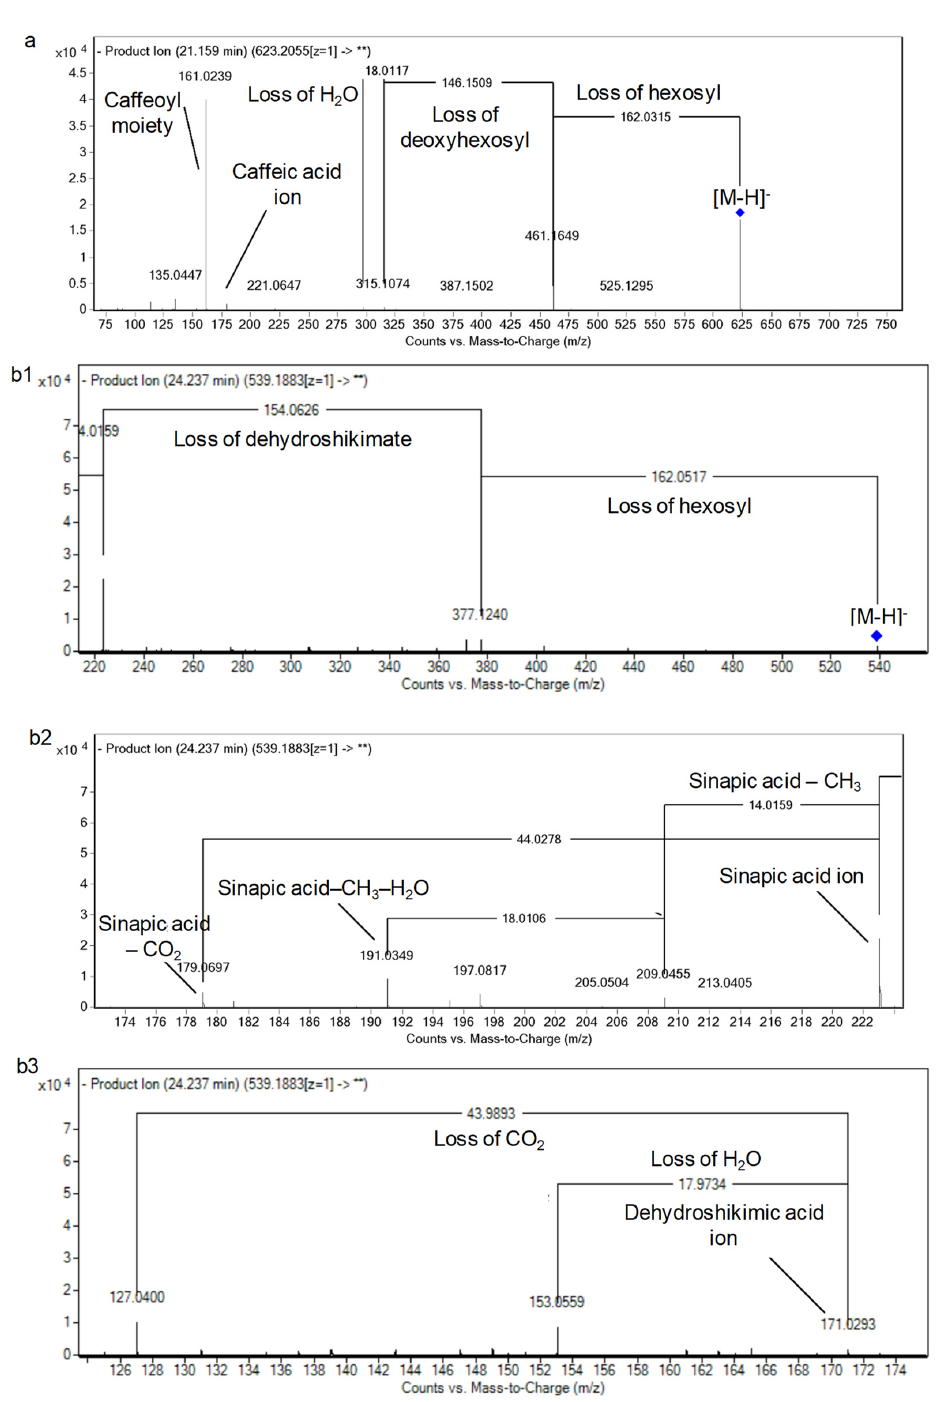
Figure 3. The patterns of fragmentation of ( a ) verbascoside, ( b ) sinapoyl-3-dehydroshikimic acid hexoside I. This spectrum has been divided ( b 1– b 3) for a better description of the fragments.